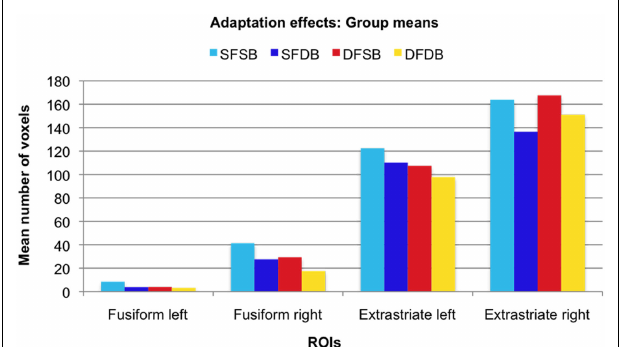
FIGURE 6 |Adaptation effects: Group means. For each ROI, the graph displays the mean number of voxels that showed significant adaptation effects for each condition.